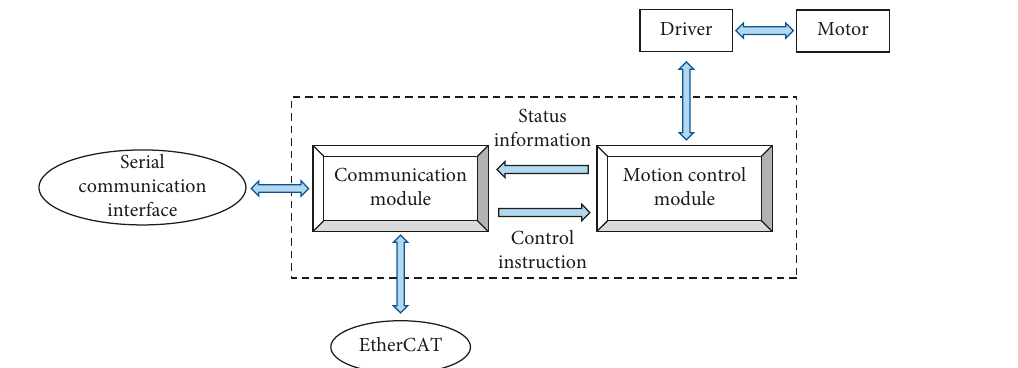
Figure 3: Motion controller